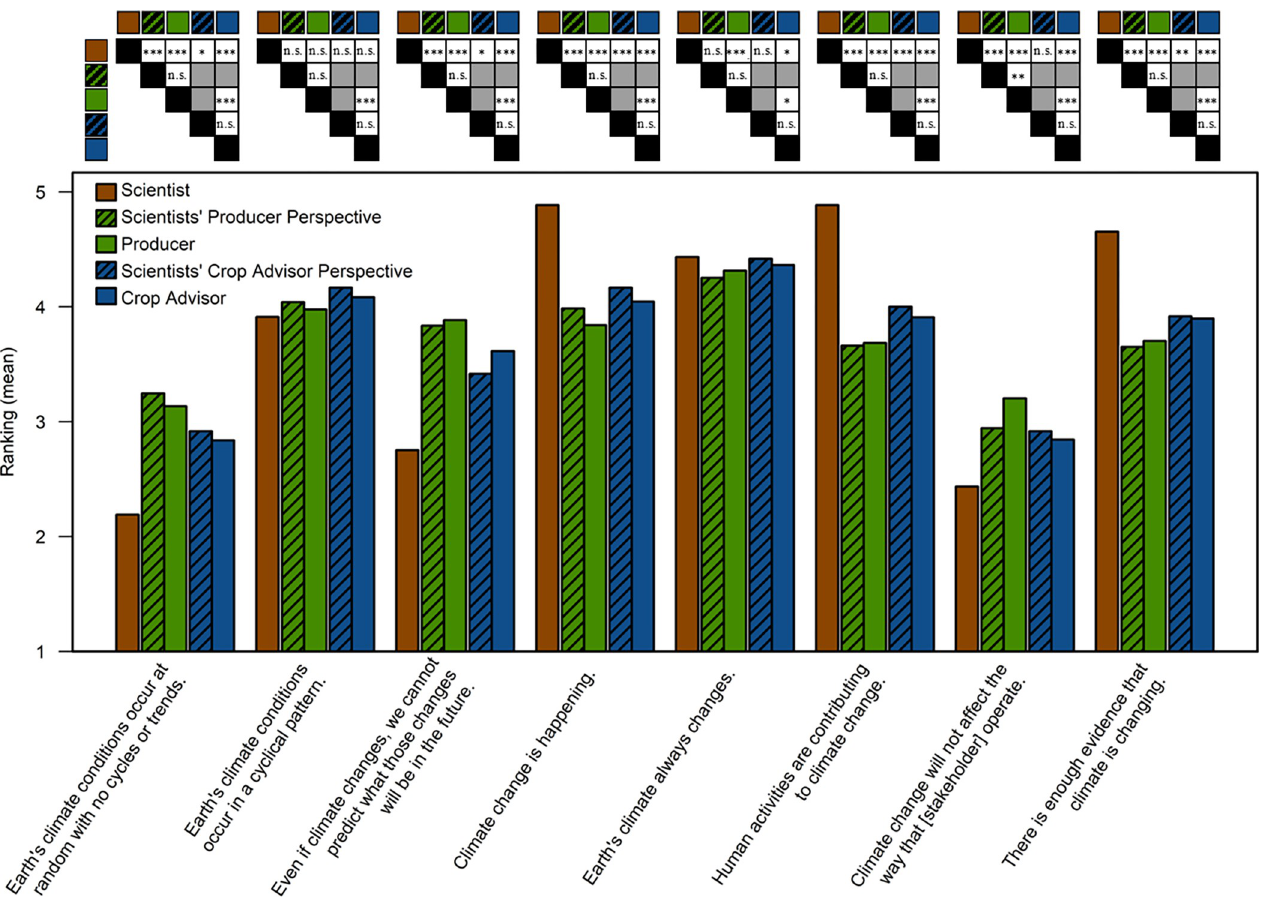
Fig 1. Scientists’ agreement with and perspectives on climate statements by producer and crop advisor compared to producer and crop advisor agreement. Significant relationships are demonstrated in tables above each statement (S2–S4 Tables). Gray indicates where pairwise comparisons were not applicable. Statistical significance is indicated by � , �� , and ��� , which corresponds to a statistical significance level at 0.05, 0.01, 0.001, respectively as well as no significance by “n.s.” The ranking scale was from 1–5, where: 1 = strongly disagree, 2 = disagree, 3 = neither agree nor disagree, 4 = agree, and 5 = strongly agree. Scientist perspectives were measured in a 2017 survey while surveys of producers (Singh et al. 2018) and crop advisors (Koundinya et al. 2017) were conducted as separately in